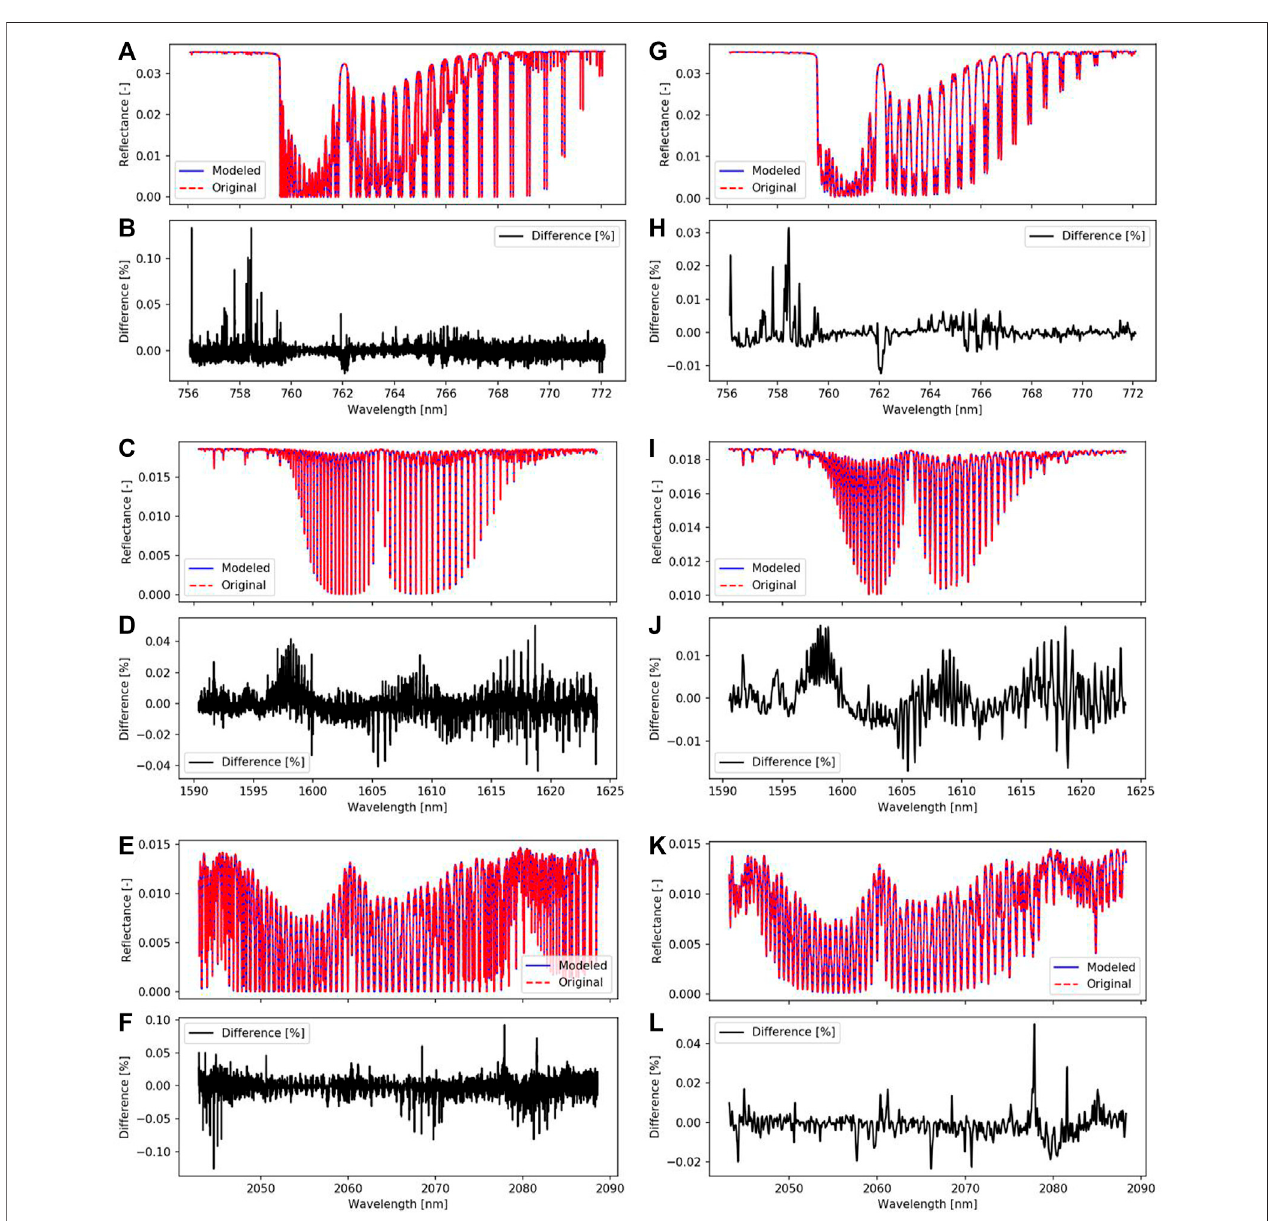
FIGURE 7 | Modeled spectra and associated errors for one representative sounding, before and after convolution with the OCO-2 instrument lineshape function, foreach instrumentchannel. O2A-band (A,B) after convolution (G,H) ;WCO2-band (C,D) after convolution (I,J) ;SCO2-band (E,F) after convolution (K,L) .Themodeled spectra are shown in blue, the original spectra in red, and the difference in percent relative to the continuum in black.